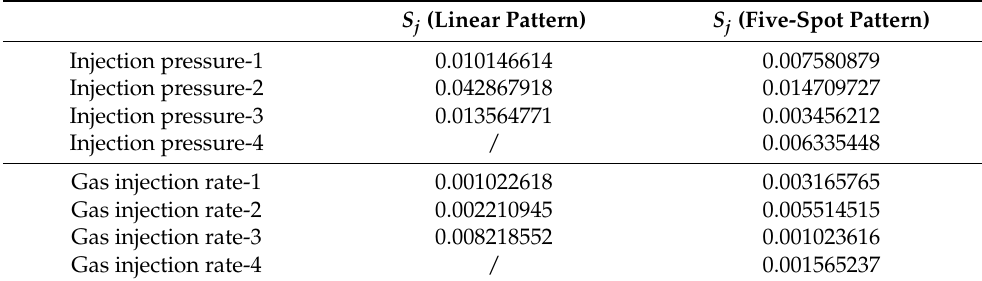
Table 2. Sensitivity calculation results for two types of well